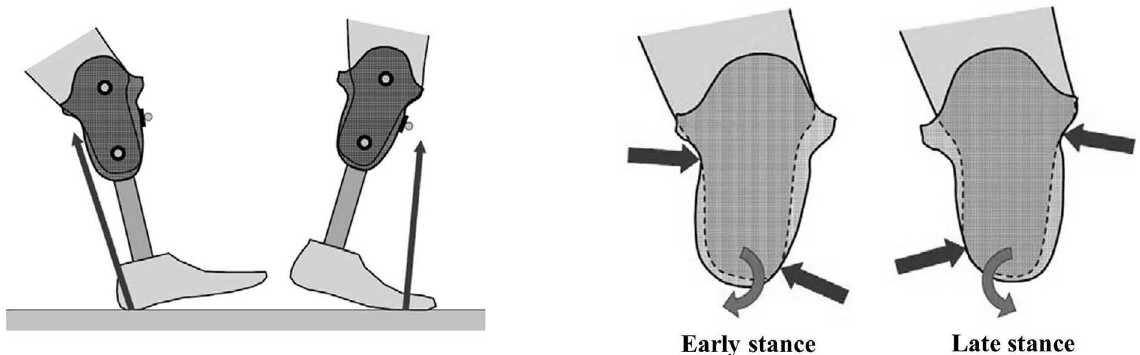
Fig 1. Drawings showing the loading extremes for level walking. The groundreaction force is behindthe distal end of the socket in early stance phaseand in front of it in late stance phase(left). The locationof the appliedgroundreactionforce causes a changein direction of the distal end sagittal torque from clockwiseto counter-clockwise (right). The areas of highest pressurebetweenthe residual limb and the socket are shown with arrows. For downhillwalking,the “early stance” torque is expectedto be increasedand prolonged.For uphill walking,the “late stance” torque is expectedto be increasedand prolonged.Movements of the residual limb within the socket are exaggerated to illustrate the effects of early and late stance torques.